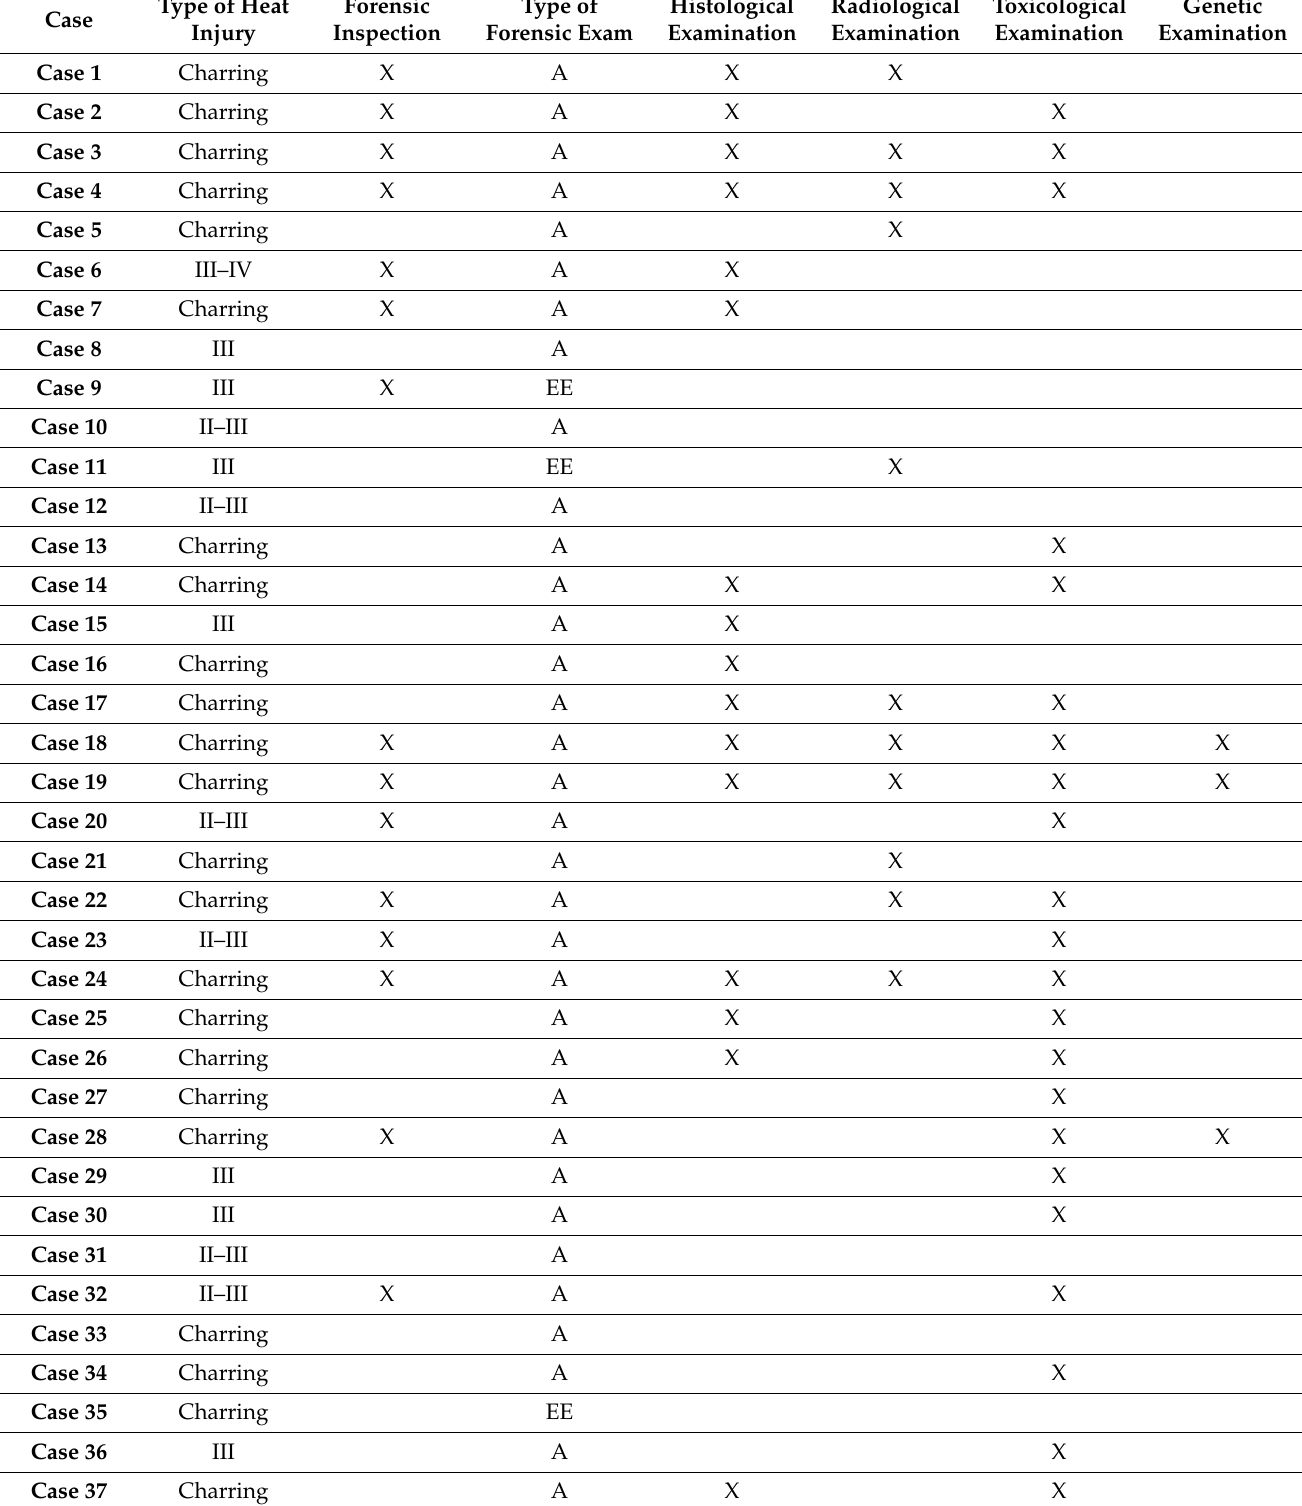
Table 1. The graphical schematization of the entire case histories analyzed. In each case, each degree of burn is described. It also indicates whether an autopsy or external inspection was performed, and whether other analyses (histological or toxicological) were required. In the column for the type of heat injury, the degree of burn is indicated (II to